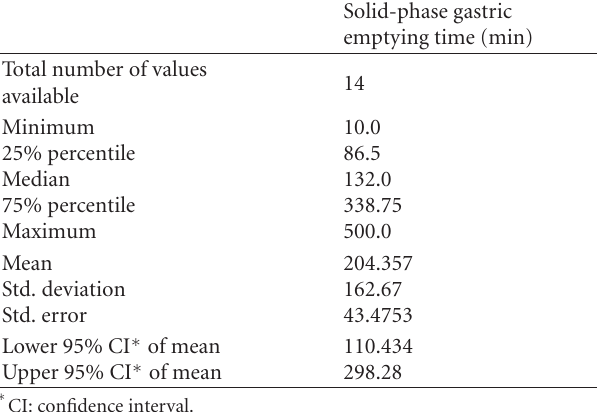
Figure 3: The distribution of mast cells based on the location in the GI tract. Mean number in the stomach was 39 cells per high-power field (hpf). Mean number in the small bowel was 57 cells per hpf. Mean number in the colon was 37 cells per